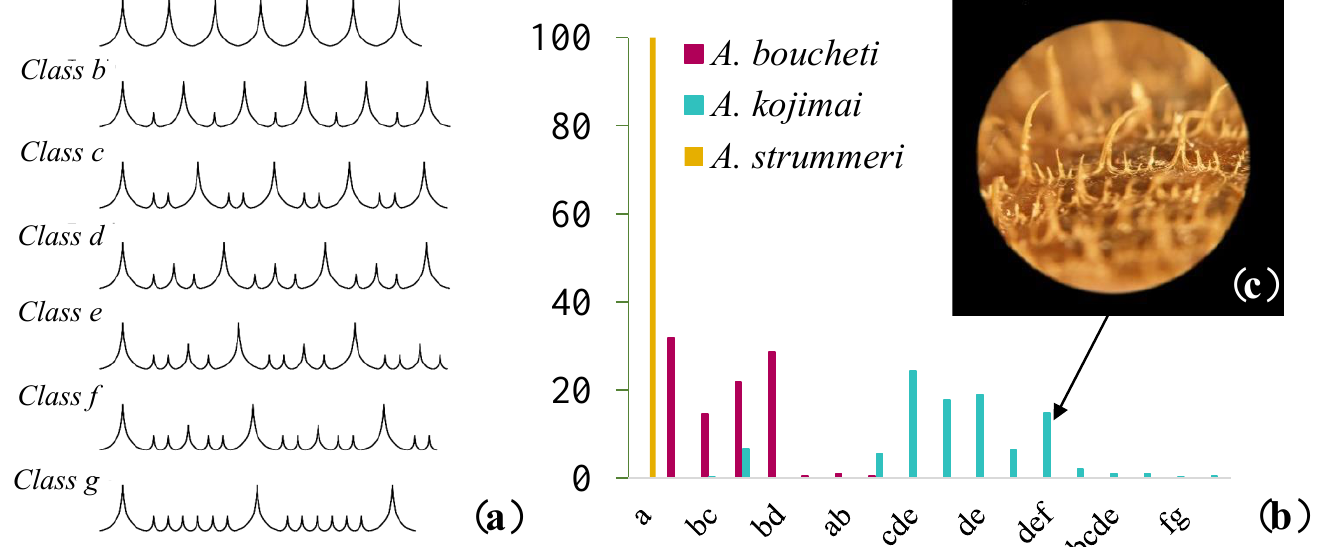
Figure 2. ( a ) Arrangement of small, medium, and large bristles on Alviniconcha shells; ( b ) percentage of bristles arrangement categories observed in each Alviniconcha species. Different categories of bristle arrangements may be encountered on the shell of a given specimen depending on the row considered, which are noted ab, bcd, etc. to account for such heterogeneity; ( c ) example of bristle arrangement for an individual of Alviniconcha kojimai.